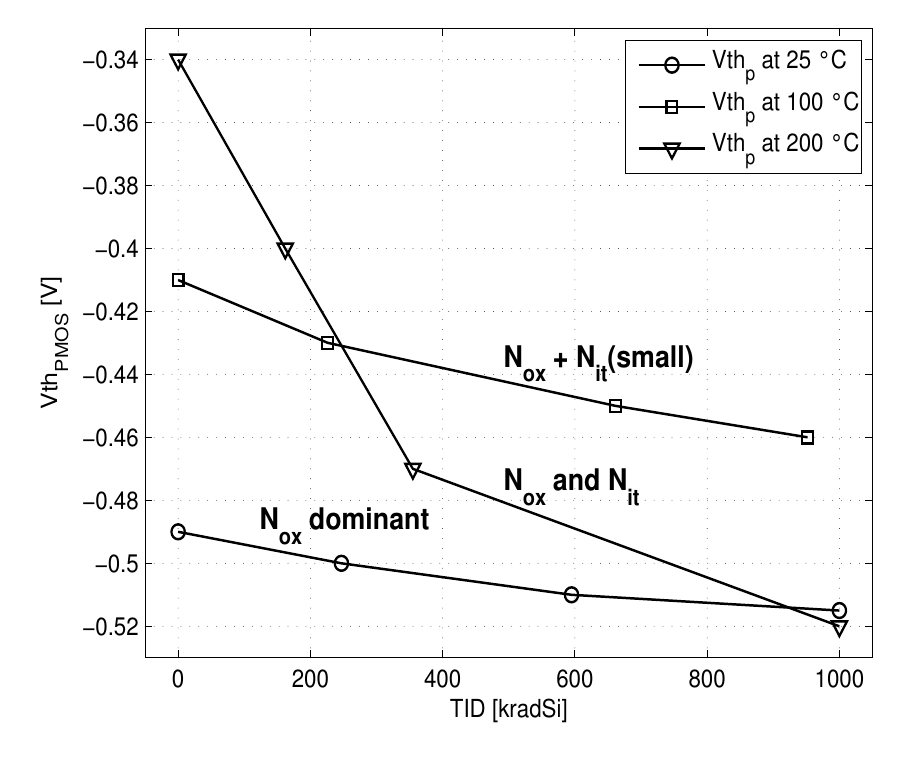
Figure 12. Measured PMOS voltage threshold vs TID at different